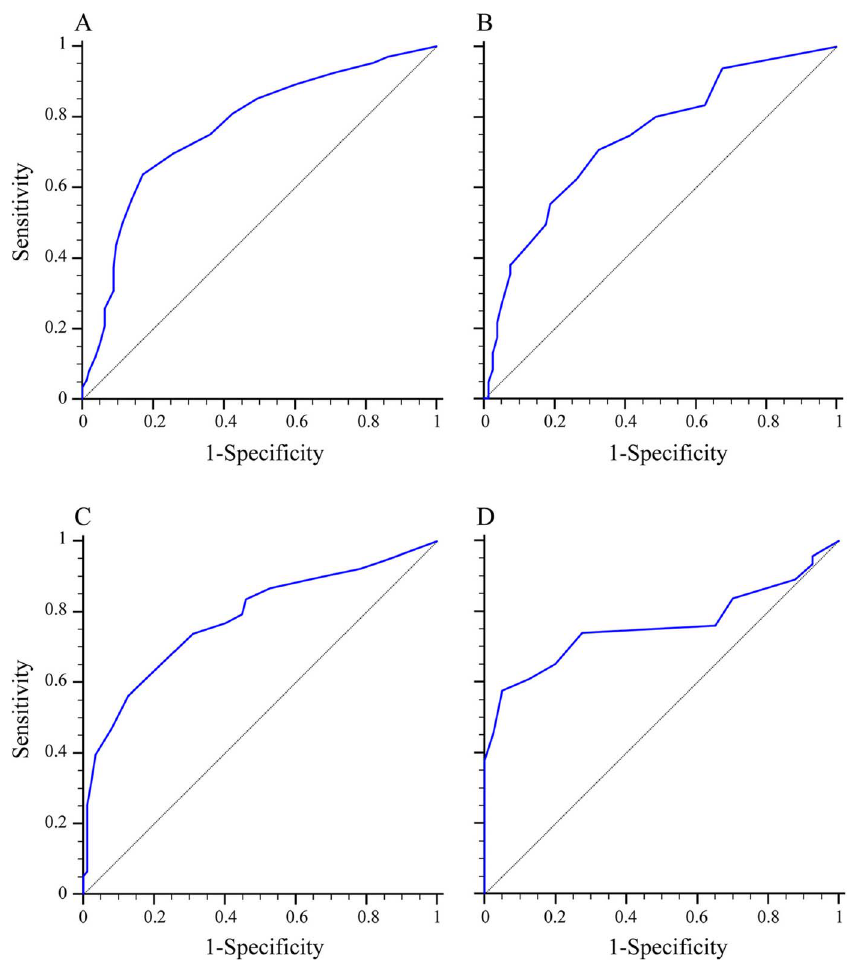
Figure 3. Diagnostic outcomes for ESS on different sexes in the diagnosis of OSA. (A) ROC curve for ESS versus PSG for male subjects in the test cohort (AUC=0.771). (B) ROC curve for ESS versus PSG for female subjects in the test cohort (AUC=0.744). (C) ROC curve for ESS versus PSG for male subjects in the validation cohort (AUC=0.781). (D) ROC curve for ESS versus PSG for female subjects in the validation cohort (AUC=0.759). ESS=Epworth Sleepiness Scale; OSA=obstructive sleep apnea; ROC curve=the receiver operating characteristics curve; PSG=polysomnography; AUC=area under the ROC curve.